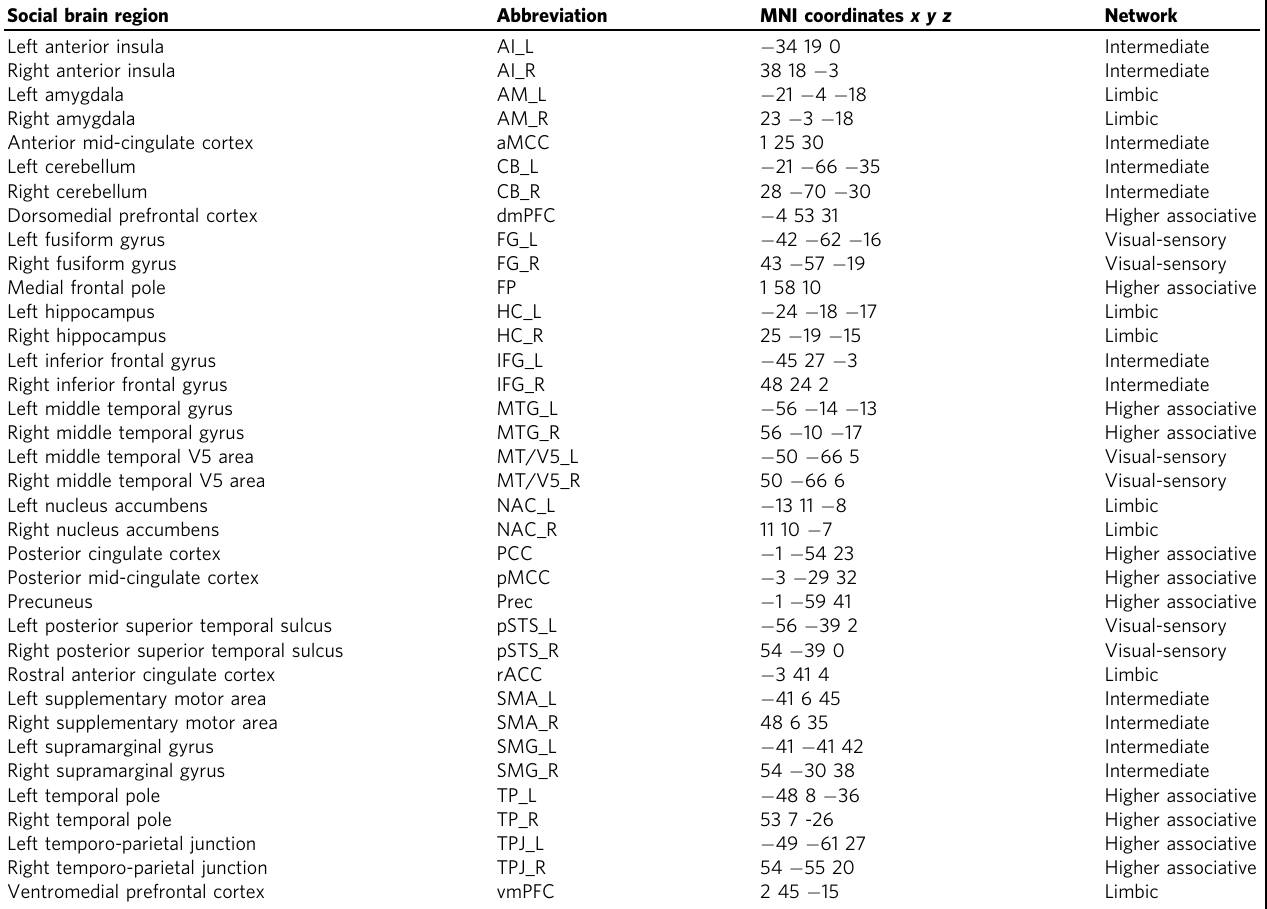
Table 3 Social brain atlas regions and their MNI coordinates. Social brain regions and their respective functional network 51 . Social brain